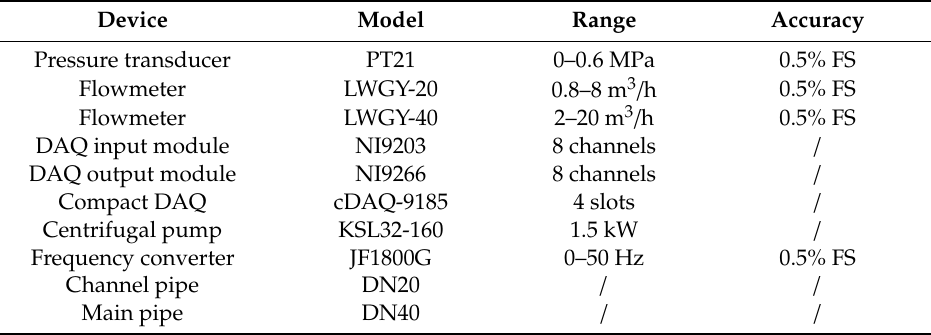
Table 1. Main characteristics of the test setup device.